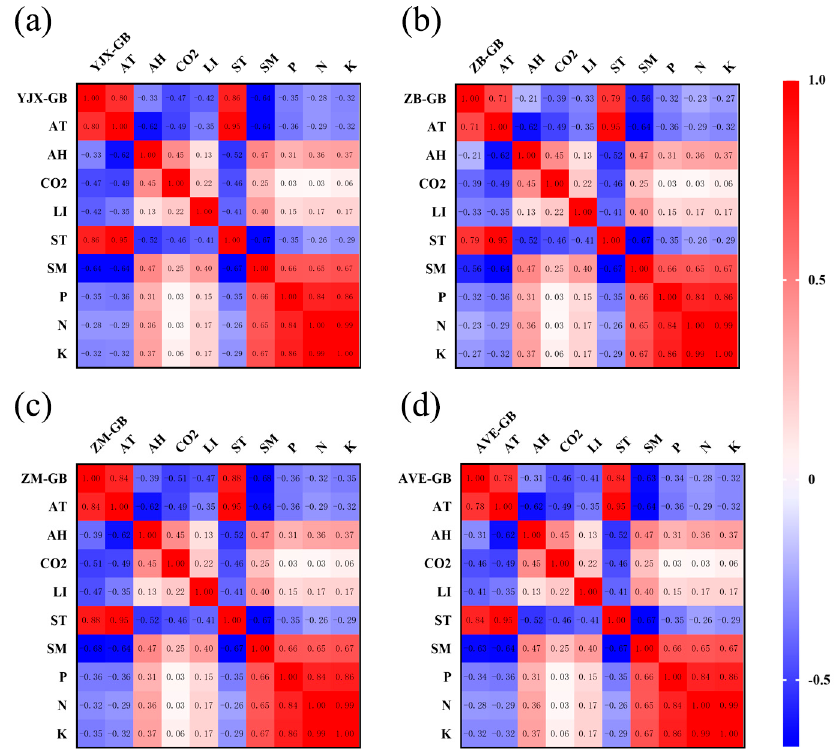
Figure 5. Pearson correlation analysis of environmental parameters and growth biomass. ( a ) YJX; ( b ) ZB; ( c ) ZM; ( d ) average correlation coefficient of YJX + ZB + ZM.